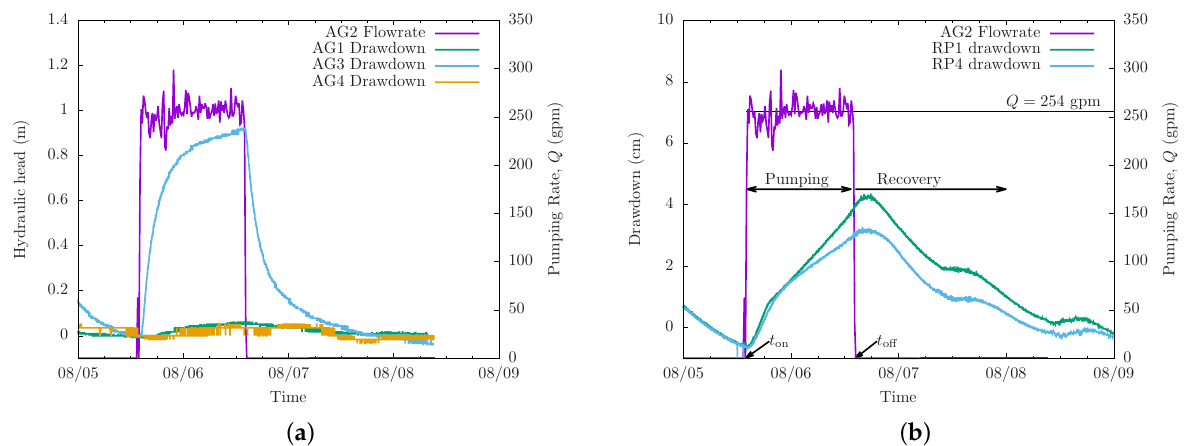
Figure 6. Drawdown responses observed in selected ( a ) aquifer observation wells and ( b ) aquitard piezometers during the second pumping test ( Q = 254 gpm = 1.60 × 10 − 2 m 3 /s) conducted at Swanton Pacific Ranch in August 2016. The pumping and recovery time periods are marked in ( b ).